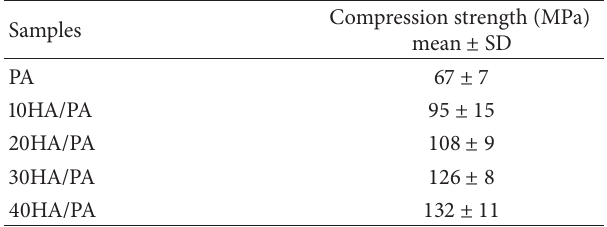
Table 1: Compressive strength of s-HA/PA